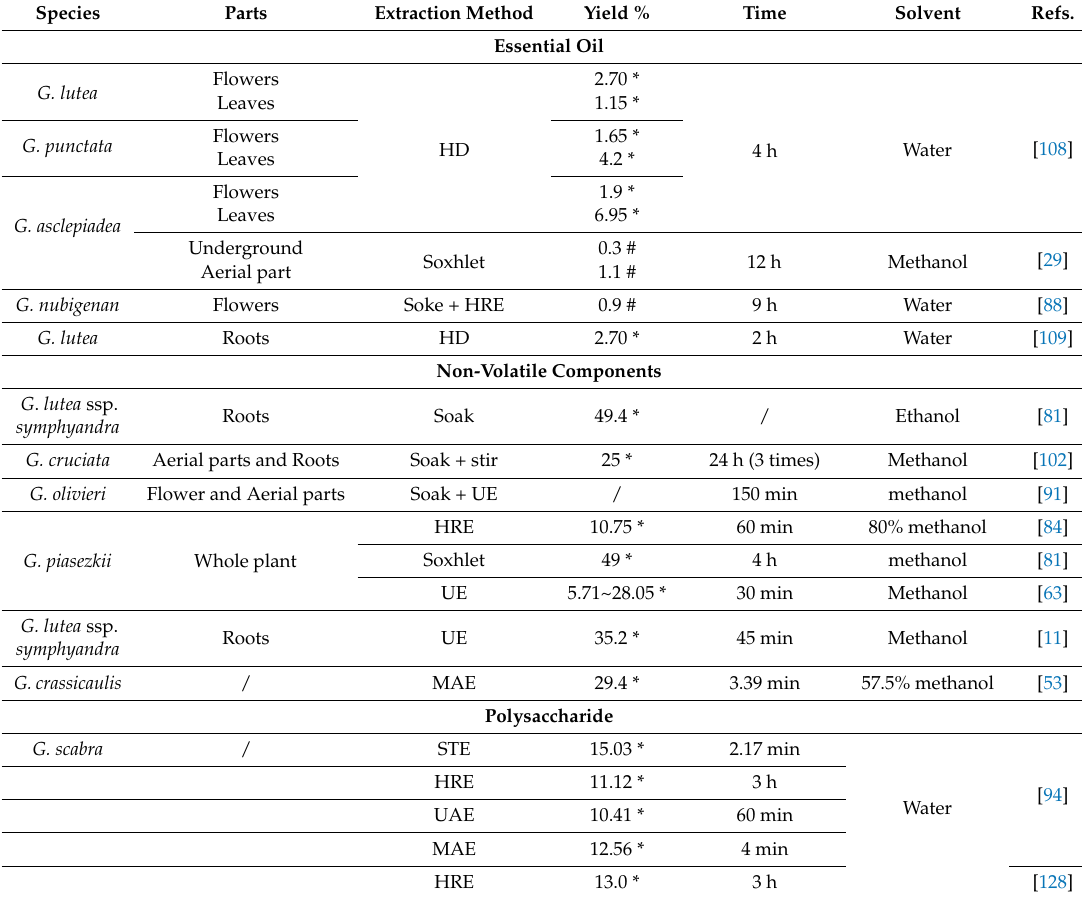
Table 3. Yield of different extraction methods in Gentiana